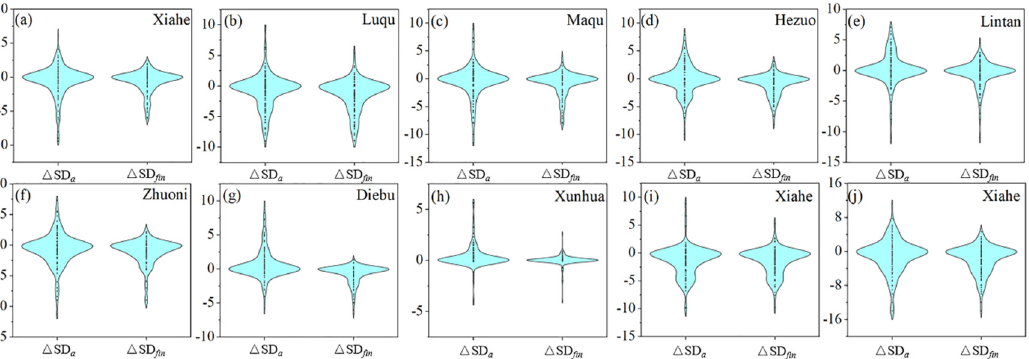
Figure 3. Evaluation of the improved downscaling method based on the differences from the gauge- based SD observations. ∆ SD a and ∆ SD fin represent the absolute error between the SD data before and after downscaling, respectively. Subplots ( a − j ) correspond to the gauge stations for snow ob- servation. Names of the stations labeled in the right corners of the plots.